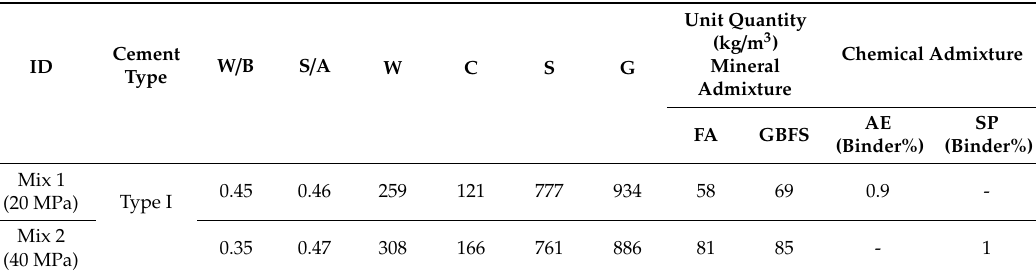
Table 1. Proportions of the concrete mixture groups 1 .